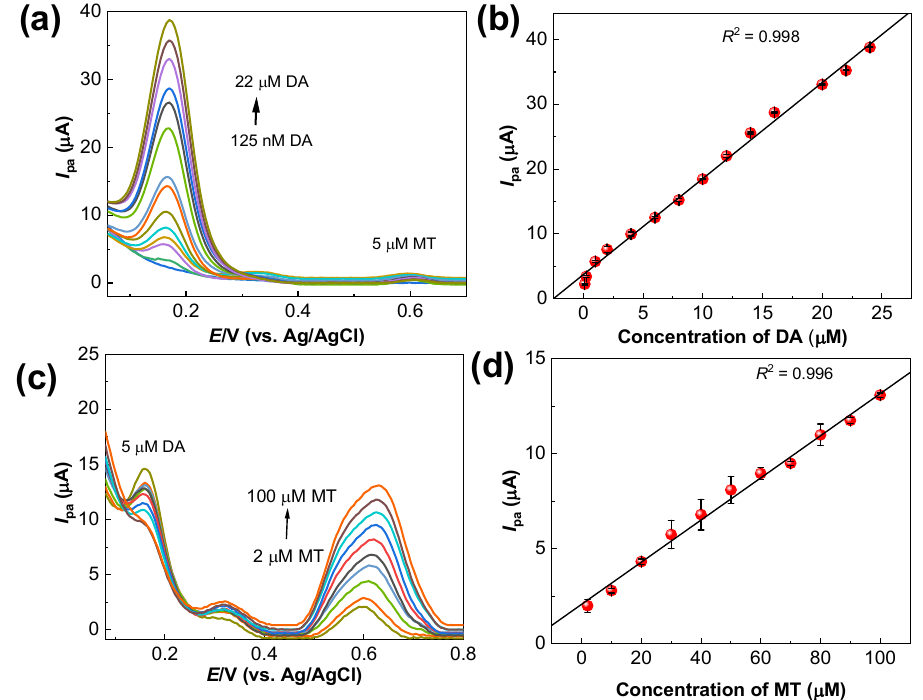
Figure 9. ( a ) DPV responses of the Cu–CNS/SPCE in increasing concentrations of DA from 125 nM to 22 μM with a fixed 5 μM concentration of MT; ( b ) DA calibration plot. ( c ) DPV curves of the Cu–CNS/SPCE in increasing concentrations of MT from 2 μM to 100 μM with a fixed 5 μM concentration of DA; ( d ) MT calibration plot.